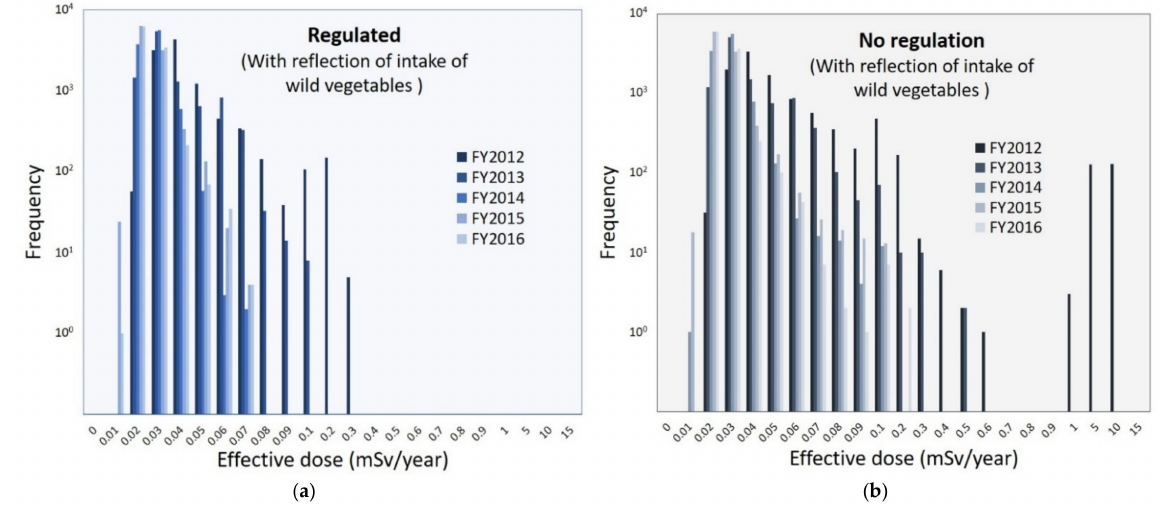
Figure 4. Radiation exposure doses of virtual 10,000 persons with the reflection of intake of wild vegetables in each fiscal year (FY): ( a ) regulation and ( b ) no regulation. The frequency of nonplotted segments (i.e., with a frequency of less than 10 0 ) was zero.